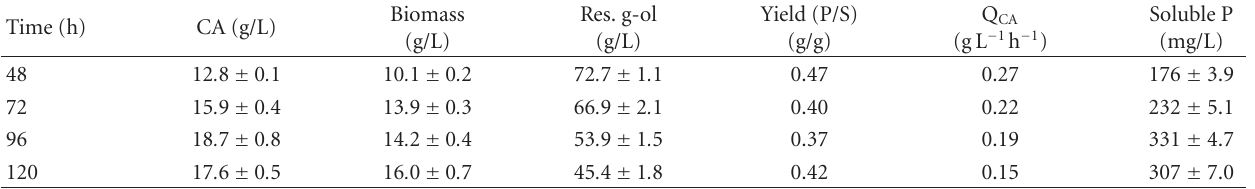
Table 1: Citric acid production and simultaneous animal bone char solubilization by free cells of Yarrowia lipolytica.